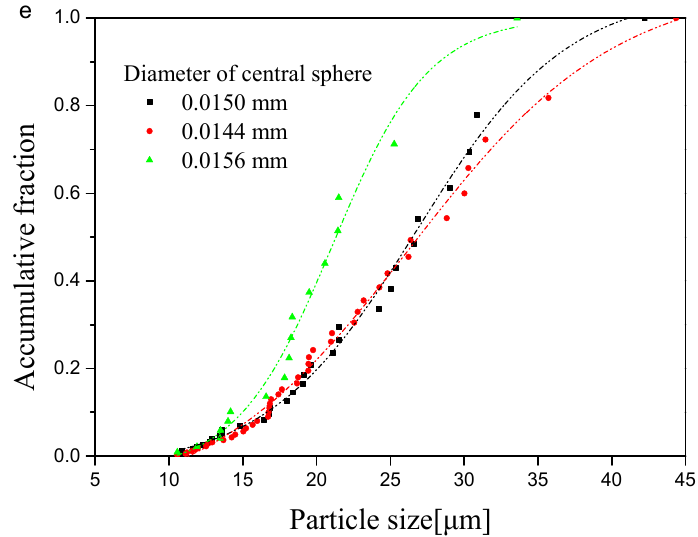
Figure 8. Comparison of ( a ) size of central sphere; ( b ) atomization of the liquid phase; ( c ) spray angle; ( d ) velocity; and ( e ) particle size distribution between cases 0, 3, and 4.